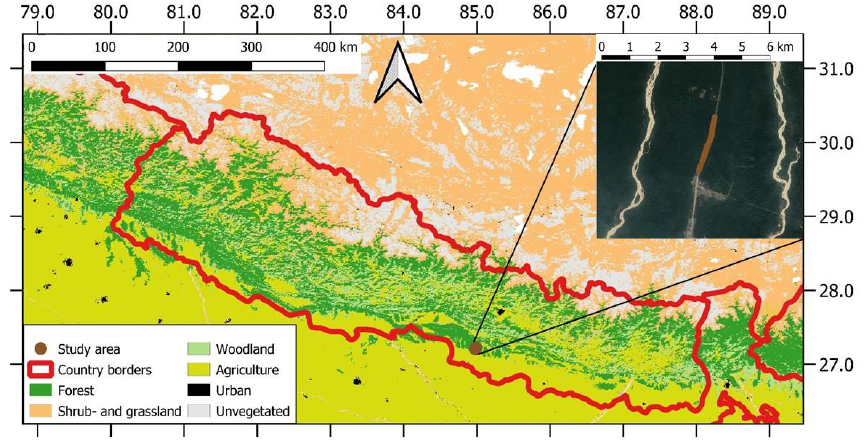
Figure 1. Location of the study area in Nepal and the main land cover types. The inserted image shows the location of the sampled trees using a Google Earth map as